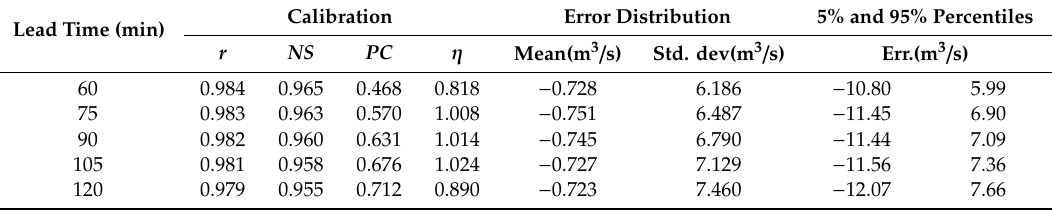
Table 6. Model-2 performance evaluation coefficients and forecasting error statistics (validation data set). Lead Time (min)